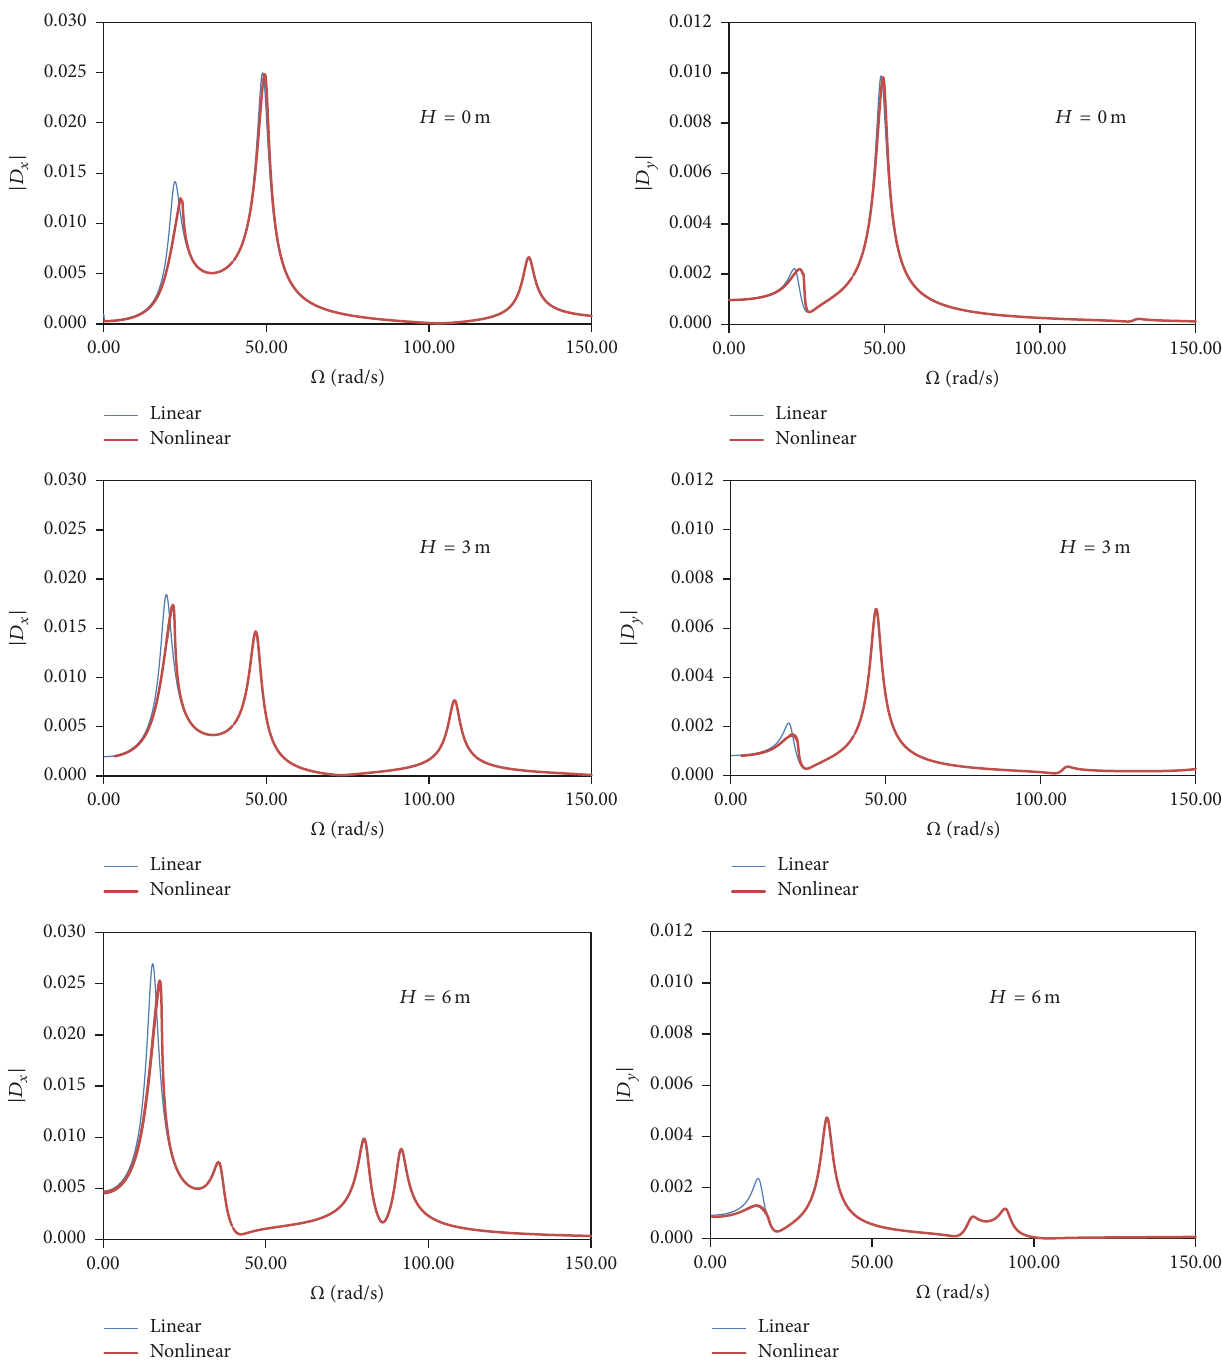
Figure 8: Variation of the norm of the vertical and horizontal vibration amplitudes at the roof top as a function of the excitation frequency for simultaneous vertical and horizontal excitation and three values of the roof height 𝐻 . 𝐴 𝑥 = 0.8𝑔 and 𝐴 𝑦 = 0.667𝐴 𝑥 .